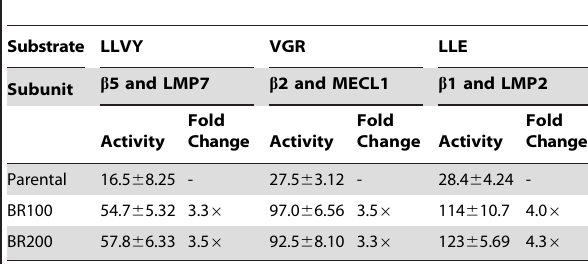
Table 2. Proteasome catalytic activity of HT-29, BR100 and BR200